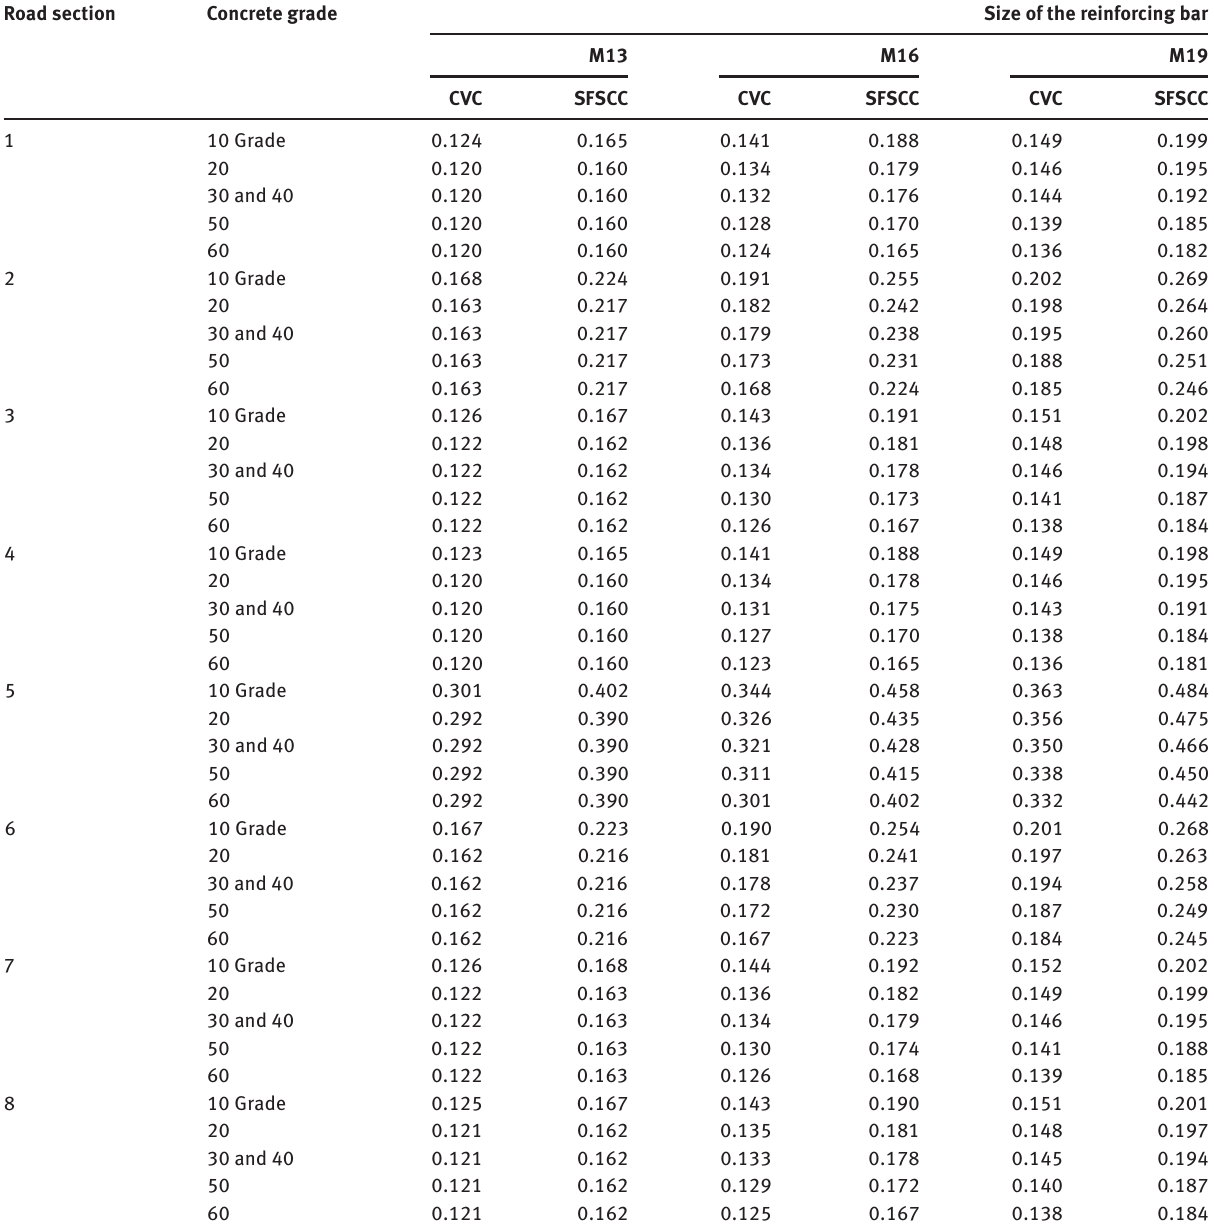
Table 3: Restraint-to-allowable stress values for various concrete grades and rebar sizes. Road section Concrete